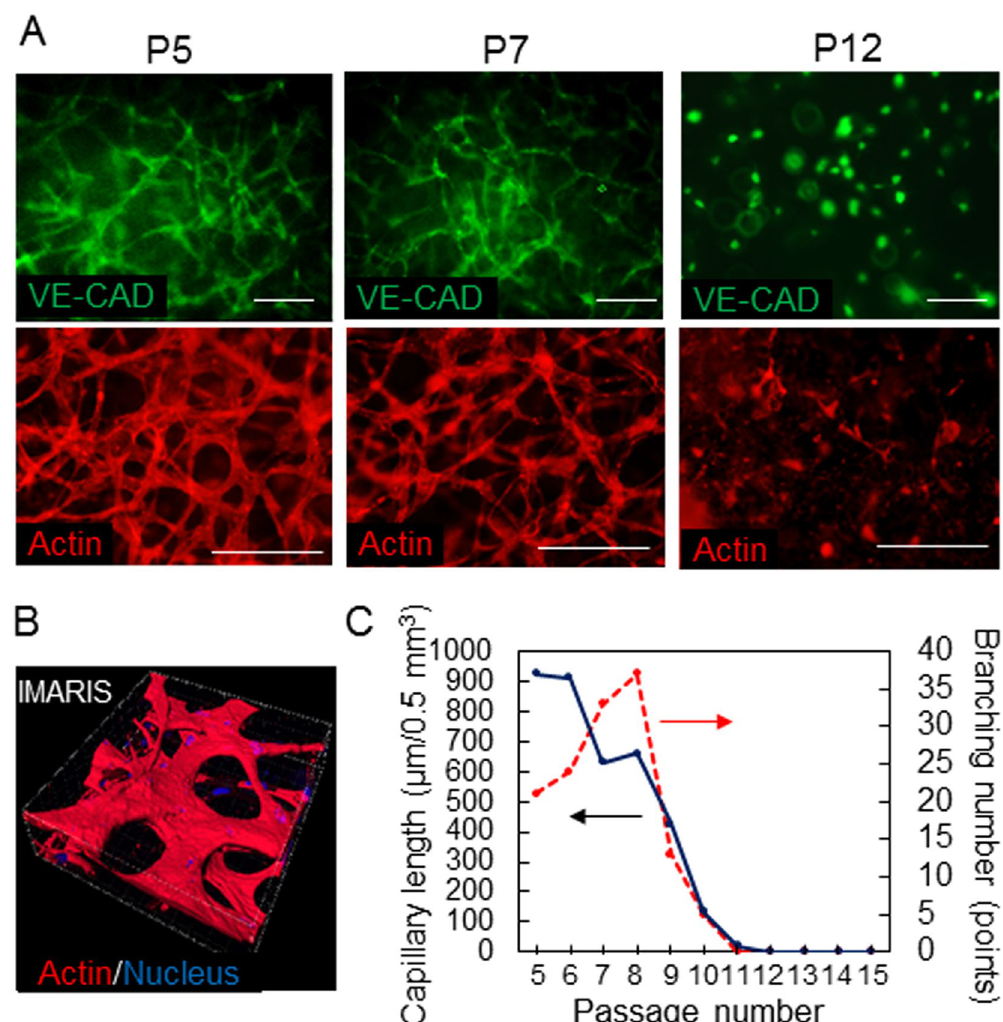
(rhodamine-phalloidin) were stained at 48 hours of culture. The scale bar is 200 μ m. ( B ) Three-dimensional configuration of vascular networks. Spatial distributions of cells at 48 hours of culture were visualized with a confocal laser-scanning microscope and were analysed using image analysis software (IMARIS). Actin (rhodamine-phalloidin) and nuclei (DAPI) were stained. ( C ) Capillary lengths and branching points were quantified using image analysis as shown in ( B